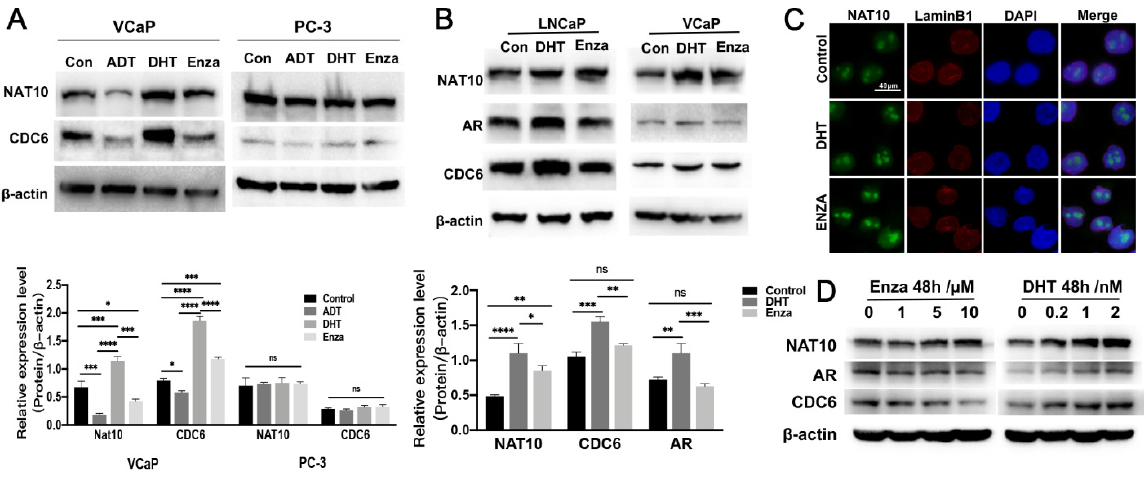
Figure 4. Altered expression of NAT10 in castration and non-castration of prostate cancer cells. ( A ) VCaP and PC-3 cells were treated with ADT, DHT (1 nM), and enzalutamide (10 µ M) for 1 week; levels of NAT10 and CDC6 in VCaP and PC-3 cells were measured by Western blotting (upper panel), and statistics were performed (lower panel). One-way ANOVA with Tukey post-hoc test; *, p < 0.05; ***, p < 0.001; ****, p < 0.0001; ns, no significance. The experiment was repeated three times. ( B , C ) Both DHT and androgen receptor antagonists increased the expression levels of NAT10. VCaP or LNCaP cells were treated with DHT (1 nM) and enzalutamide (10 μ M) for 48 h, and then subjected to Western blotting analysis ( B ) and immunofluorescence staining ( C ). ( B ) Levels of NAT10, AR, and CDC6 in VCaP and LNCaP cells were measured by Western blotting (upper panel), and statistics were performed (lower panel). One-way ANOVA with Tukey post-hoc test; *, p < 0.05; **, p < 0.01; ***, p < 0.001; ****, p < 0.0001; ns, no significance. ( C ) NAT10 (green), lamin B1 (red), and DAPI (blue). ( D ) DHT or enzalutamide gradient concentration treatment for 48 h. Levels of NAT10, AR, and CDC6 were measured in LNCaP cells.